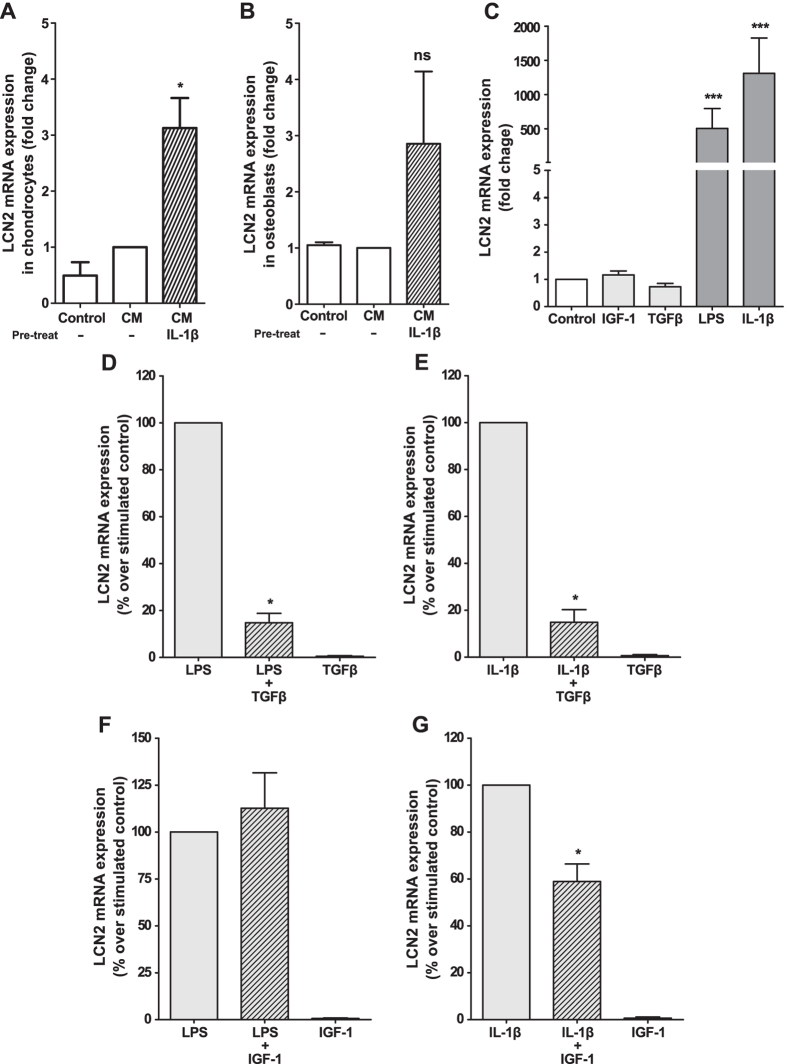
Modulation of LCN2 in osteoblast-chondrocyte crosstalk and in primary human chondrocytes.Primary human osteoblasts and chondrocytes were grown until confluence and stimulated with 1 ng/ml IL-1β for 24 h. After washing, CM was collected and used to stimulate human chondrocytes (A) or osteoblasts (B). Primary human chondrocytes were grown until confluence and then stimulated with 10 ng/ml TGF-β1, 100 ng/ml IGF-1, 1 μg/ml LPS or 1 ng/ml IL-1β alone (C) or with combined anabolic and pro-inflammatory factors (D–G) for 48 h. LCN2 mRNA expression was measured by real-time PCR. The results are presented as the mean ± SEM of at least four independent experiments and expressed as the fold-change over the non-stimulated CM (A,B), non-stimulated control (C) or as the percentage over the stimulated control (D–G). (*p < 0.05, ***p < 0.001, ns: non-significant).